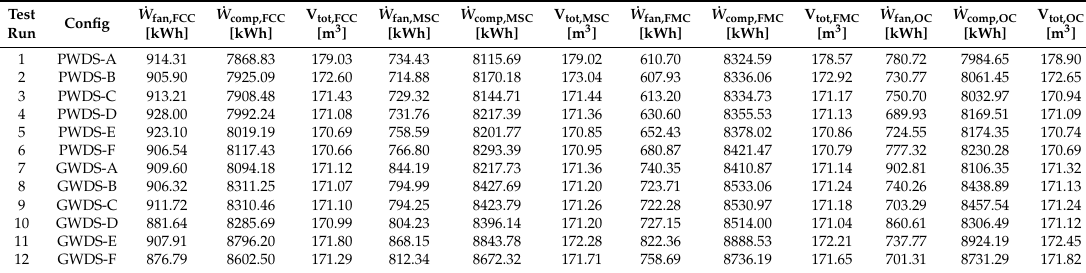
Table 6. Simulation